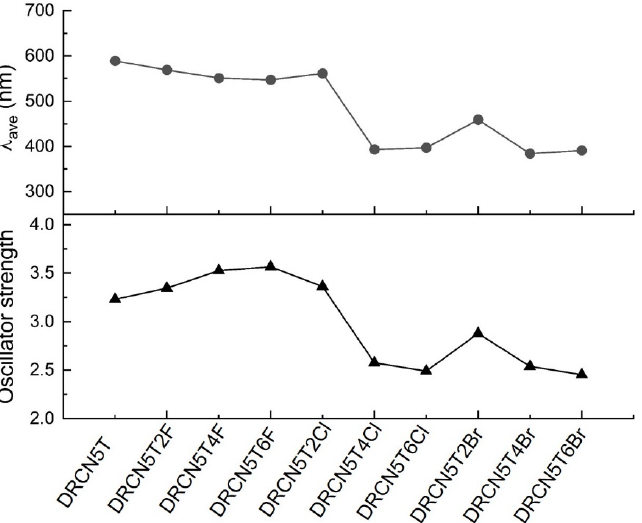
Figure 11. The averaged wavelength of absorption peaks and the total oscillator strength of the hal- ogenated molecules.